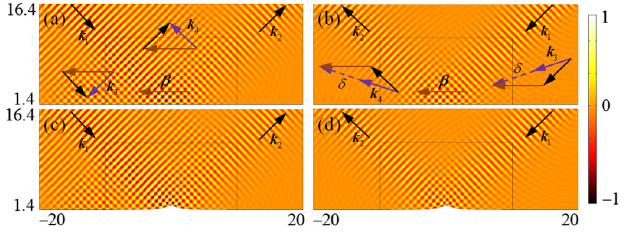
5. The pressure-field maps in (a),(b) the virtual space and (c),(d) the physical space for a one-way invisible PT -symmetric acoustic ground cloak. In (a) and (c), where the plane wave is incoming from the left, a strong backreflection can be observed due to the satisfied phase matching, and therefore, the observers on the left can sense the existence of the ground cloak. However, in (b) and (d), where the plane wave is incident from the right, the waves propagate without any scattering due to phase mismatching, and thus, an arbitrary object can be concealed in the bump region. The wavelengths of incident waves are λ ¼ 0 . 8